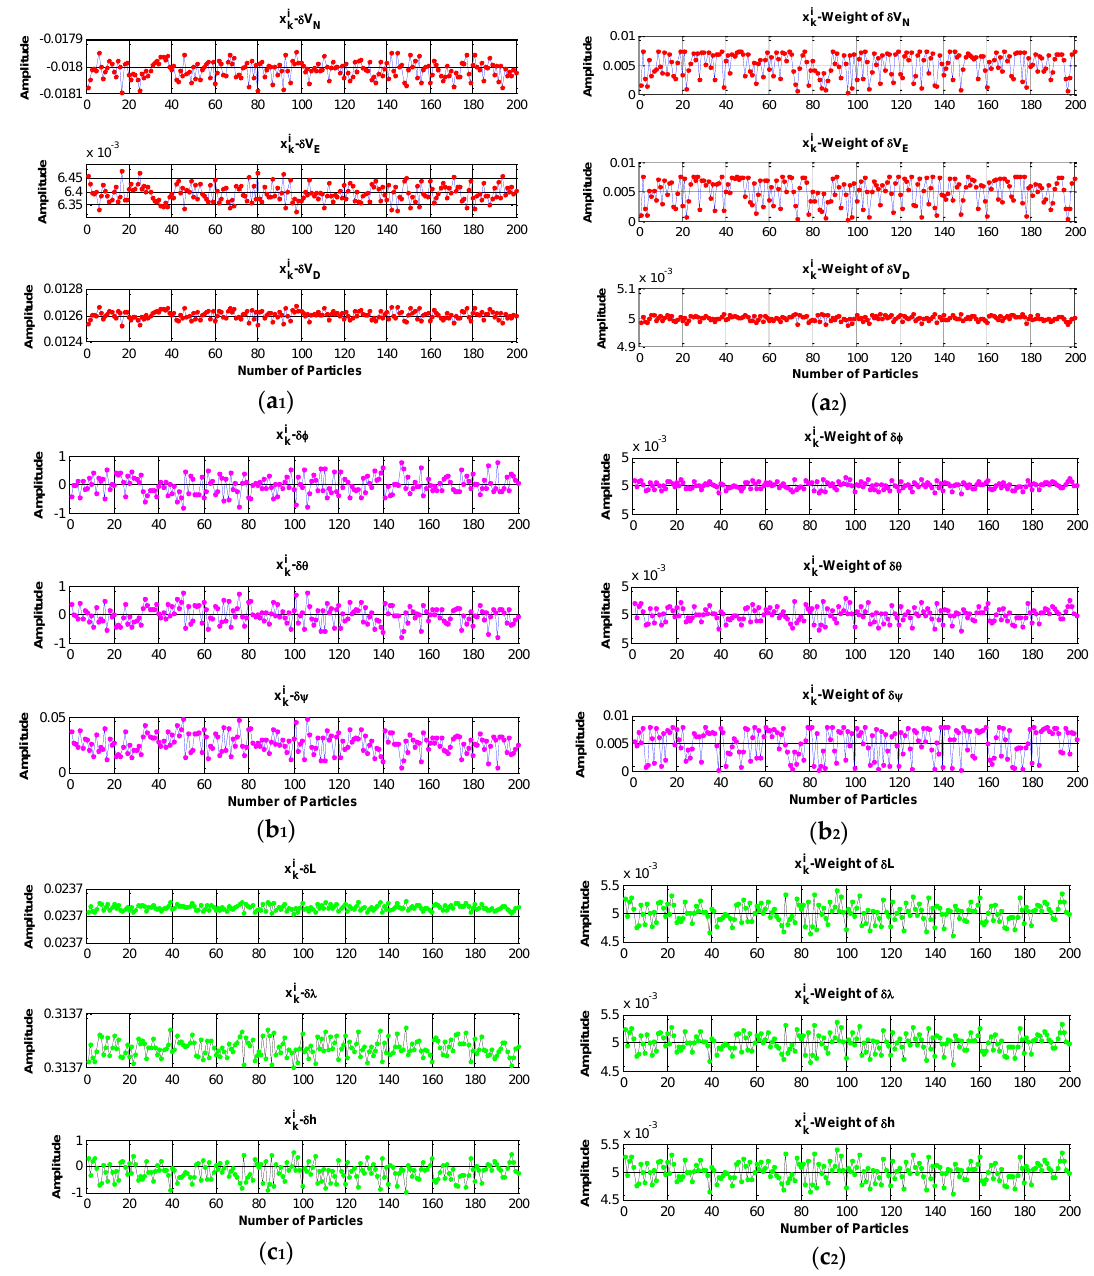
Figure 7. Particles or samples, along with the corresponding weights for evaluation of the posterior function. ( a 1 ) and ( a 2 ) are particles of velocity errors and the corresponding weights; ( b 1 ) and ( b 2 ) are the particles of attitude errors and the corresponding weights; ( c 1 ) and ( c 2 ) are the particles of positon errors and the corresponding weights. The priori pdf is the importance density function. The designator δL , the same as δφ , is the latitude error.